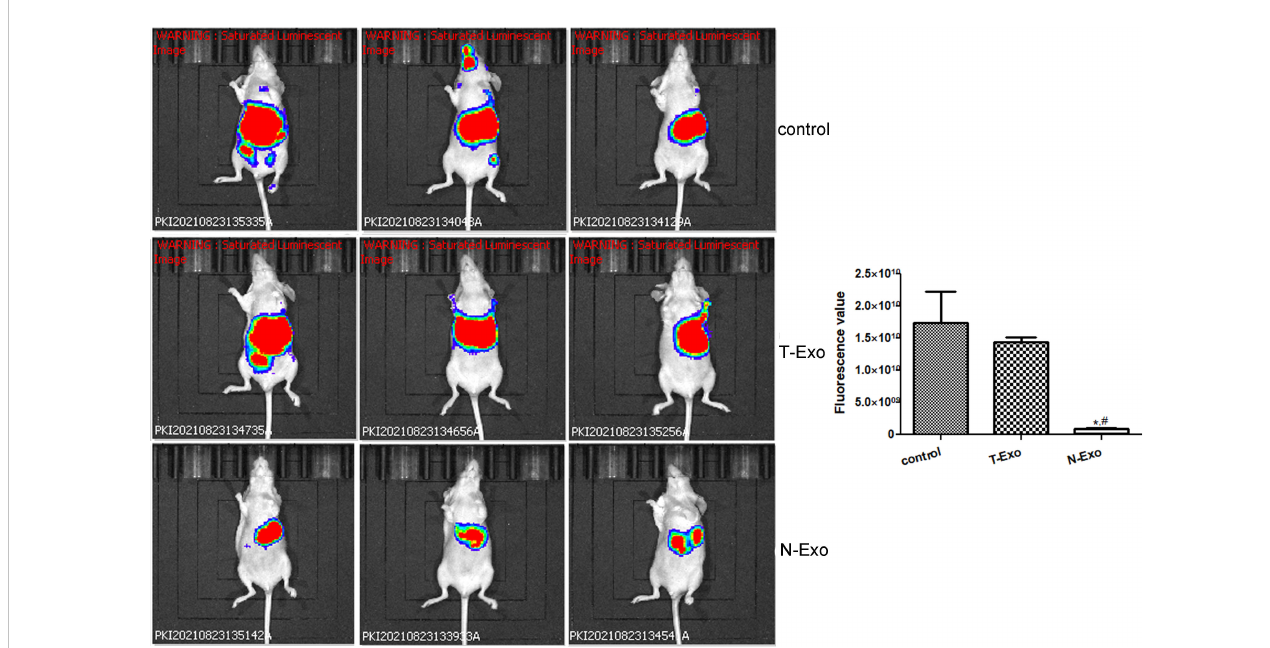
FIGURE 2 Representative images of in vivo imaging and quantitative analysis in the mice with different treatments. *: P < 0.05, compared with the control group; #: P < 0.05, compared with the T-Exo group. T-Exo: plasma-derived exosomes from thin camels; N-Exo: plasma-derived exosomes from normal